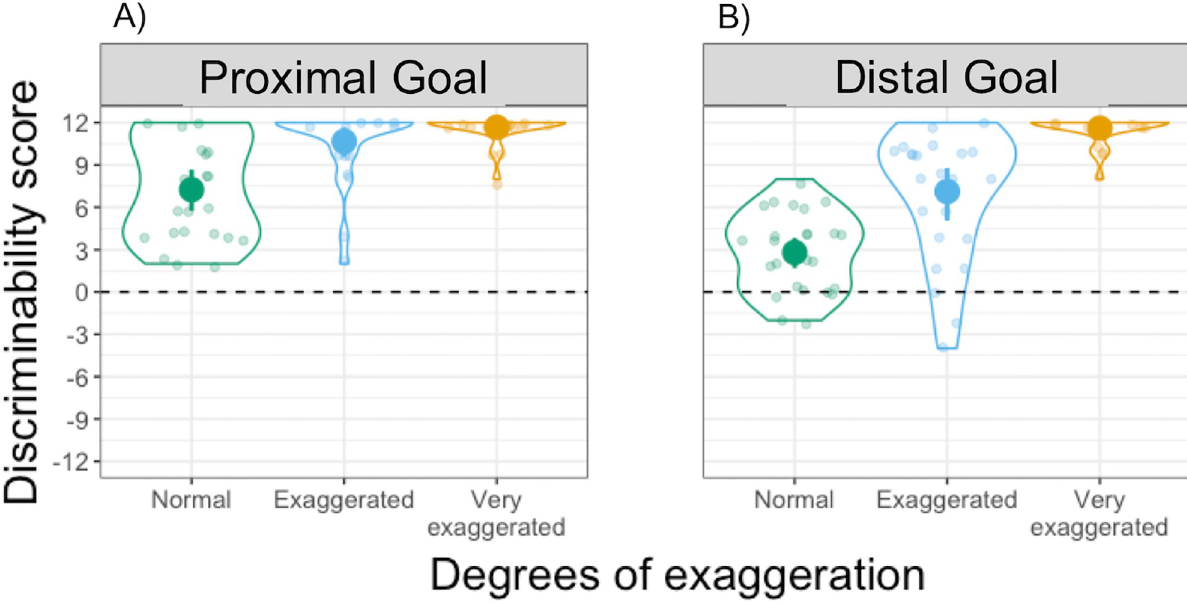
Fig 5. Discriminability scores in Experiment 2. Distribution of Discriminability scores in the (A) Proximal goal and the (B) Distal goal conditions, for the three degrees of exaggeration. The dashed line indicates chance discriminability (i.e., that movement velocities are not discriminable).